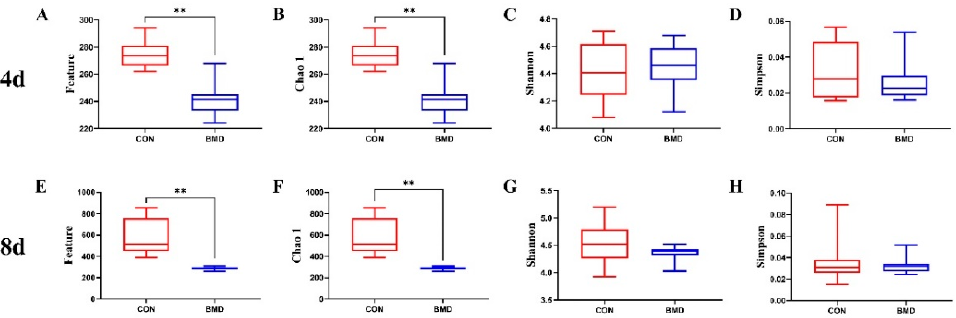
Figure 1. The α -diversity of the gut microbiota in the caecum of broilers in the CON and BMD groups. Features ( A , E ), Chao 1 ( B , F ), Shannon ( C , G ), and Simpson ( D , H ) were determined to elucidate the diversity and richness of the microbial community in the caecum of the broilers in the CON and BMD groups. In addition, ( A – D ) represent 14 days (n = 24, CON = 12, BMD = 12), and ( E – H ) represent 28 days (n = 23, CON = 12, BMD = 11). A two-tailed unpaired Student’s t- test was used to analysis the data, ** p < 0.05.